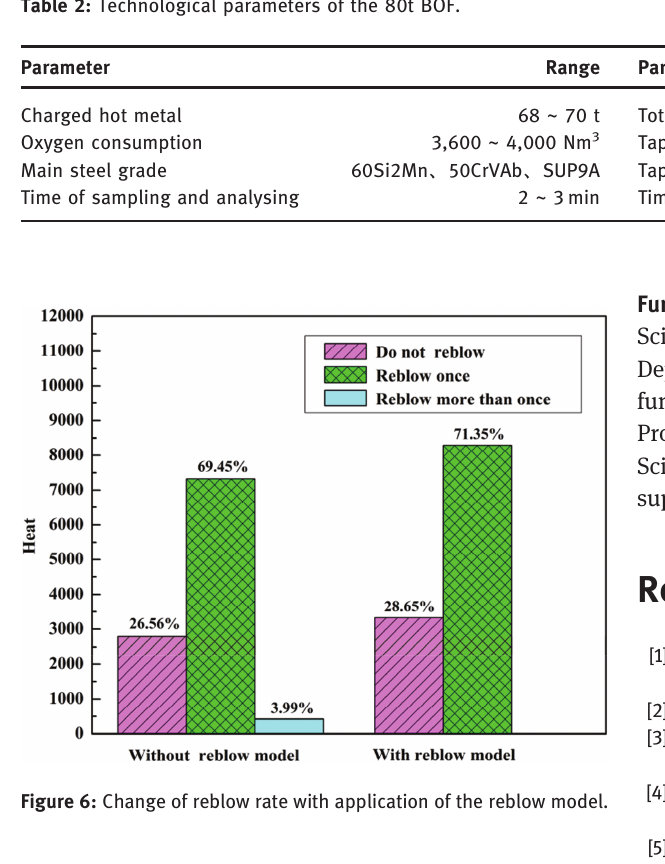
Table 2: Technological parameters of the 80t BOF.